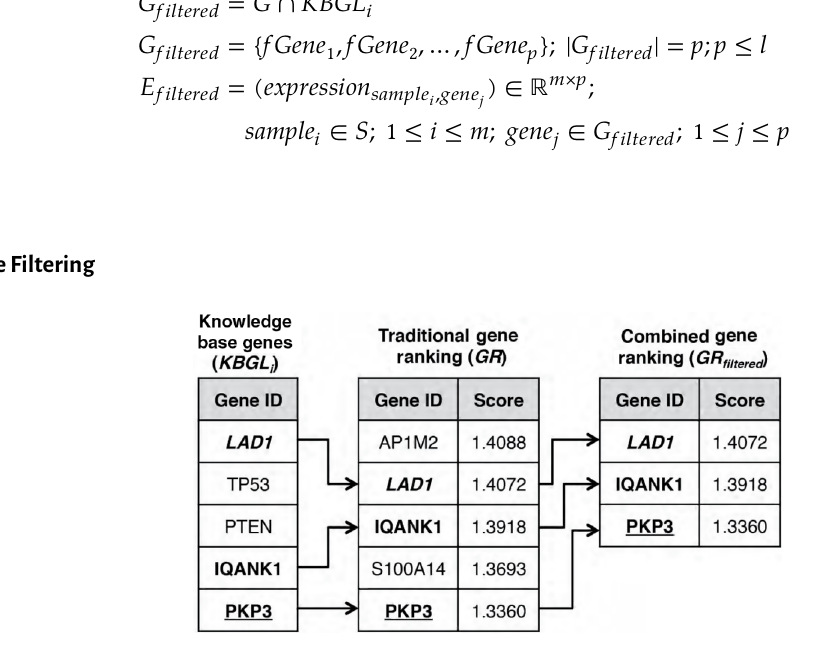
Figure 3: Gene filtering example showing the filtering of a traditional gene ranking by retaining only genes extracted from a knowledge